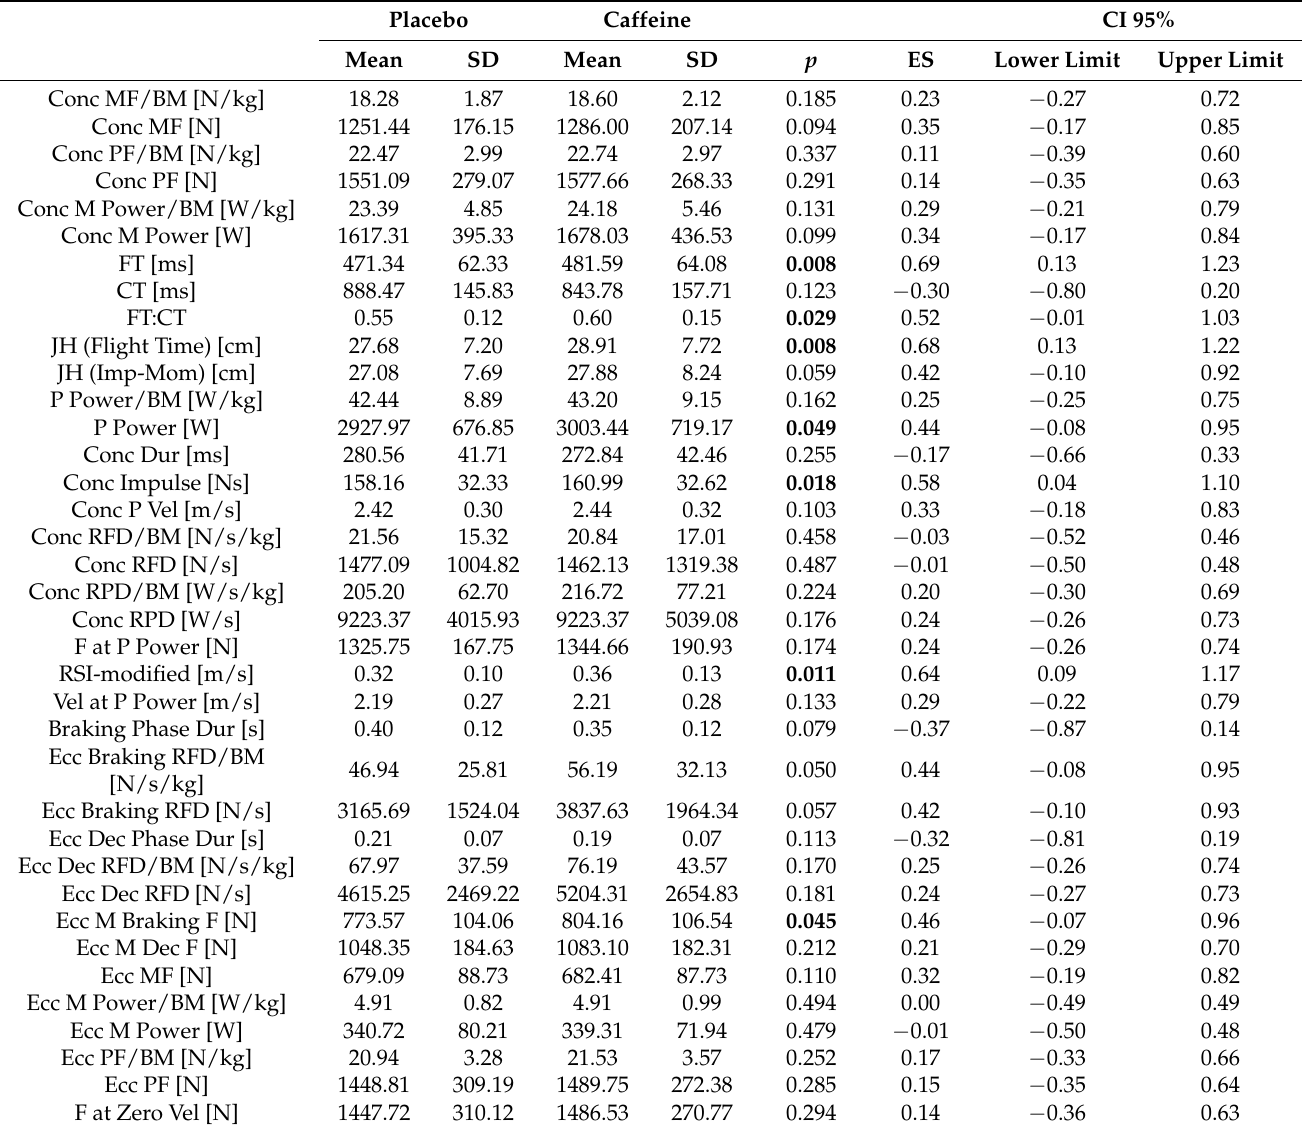
Table 2. Kinetic and kinematic differences between Caffeine and Placebo conditions in the bilateral CMJ. Placebo